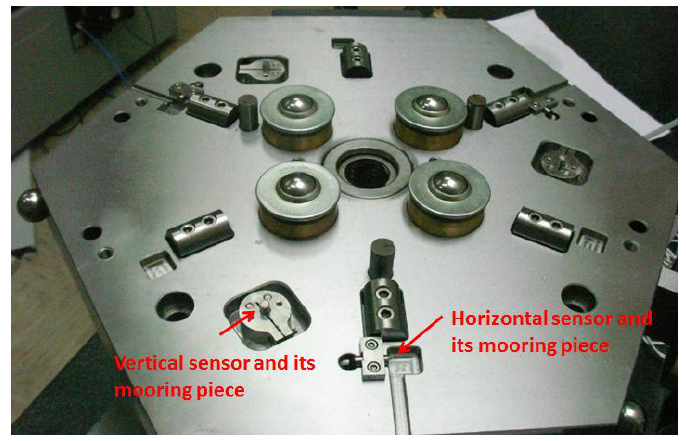
Figure 14. Capacitive sensors with their mooring